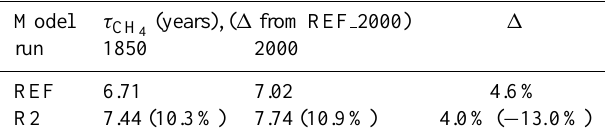
Table 3. As for Table 2, except for tropospheric, annual mean CH 4 lifetime τ CH 4